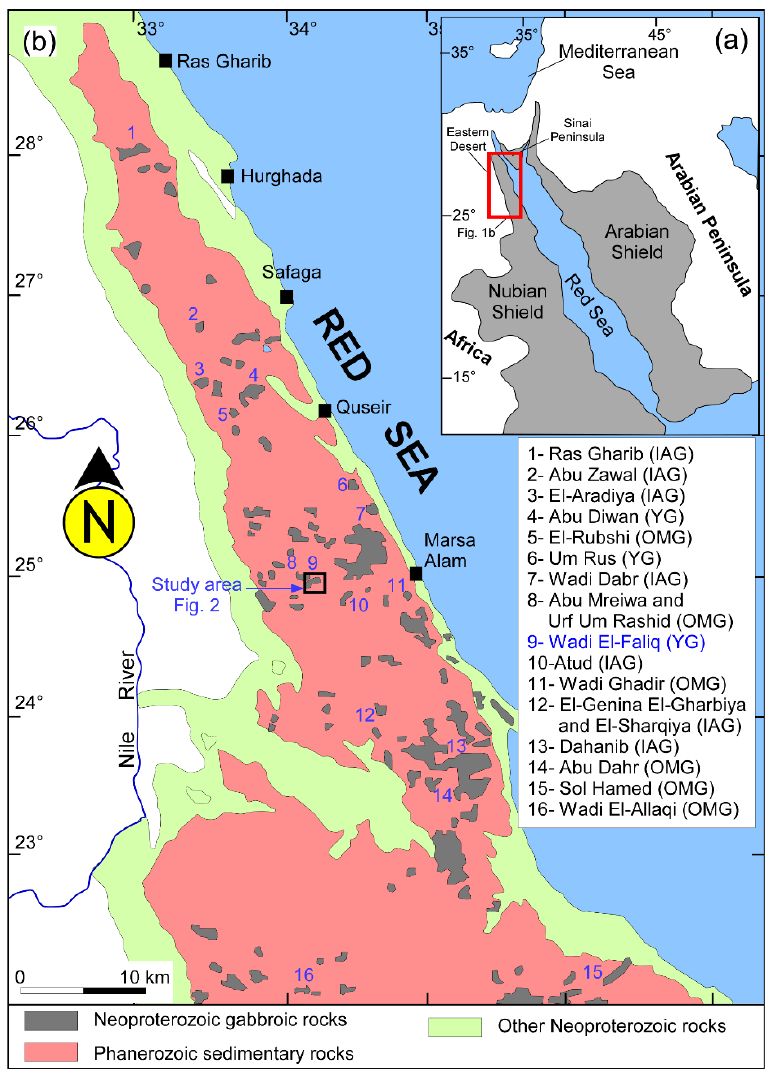
Figure 1. ( a ) A schematic general map of the ANS; ( b ) the distribution of various Neoproterozoic gabbroic rocks in the Eastern Desert of Egypt (modified after Abdelfadil et al. [15] ). OMG: ophiolitic metagabbro; IAG: island arc gabbro; YG: younger gabbro.